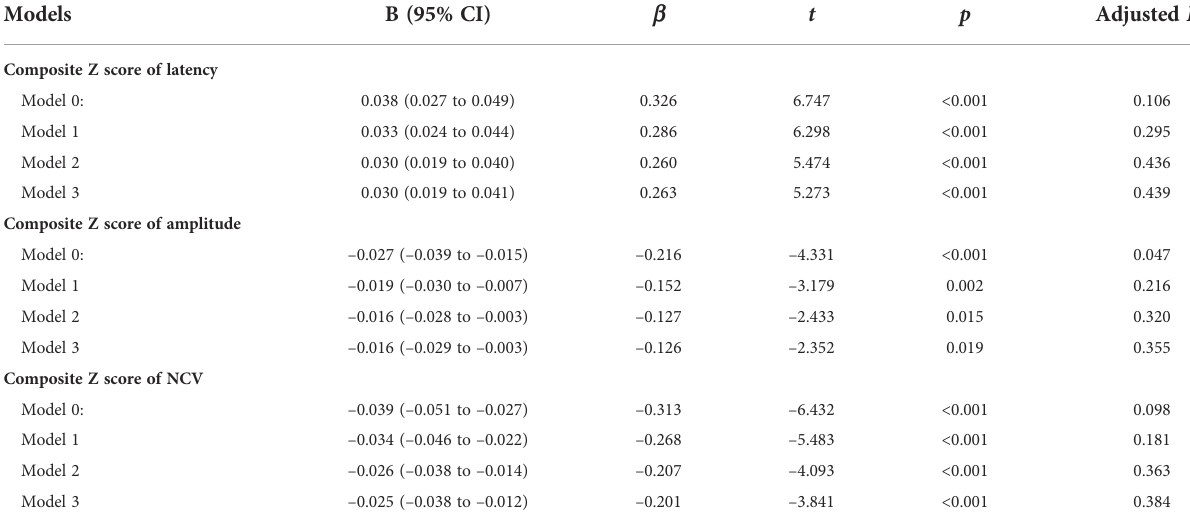
TABLE 2 Impacts of serum ADA levels on nerve conduction indices by multivariable linear regression analysis. Models